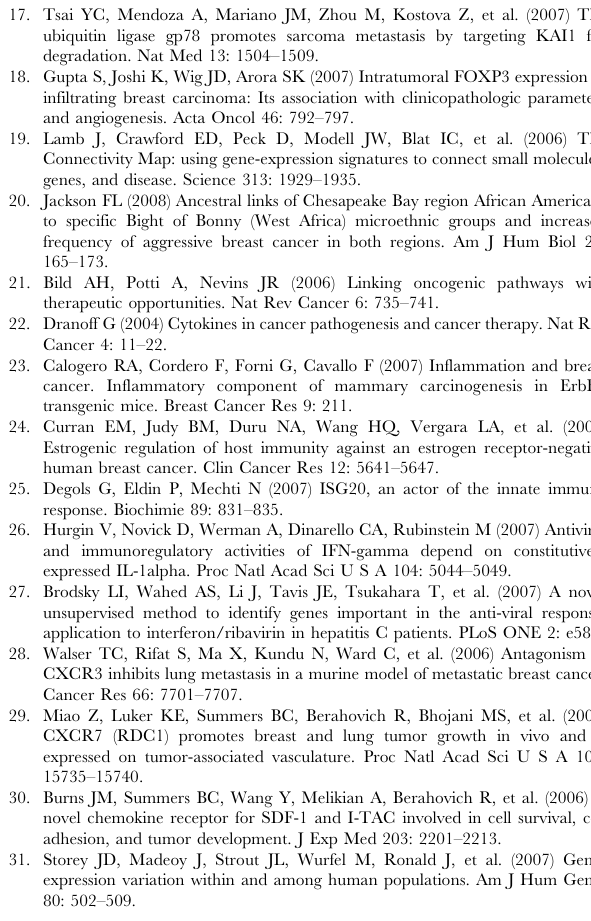
Found at: doi:10.1371/journal.pone.0004531.s004 (0.02 MB Found at: doi:10.1371/journal.pone.0004531.s005 (0.01